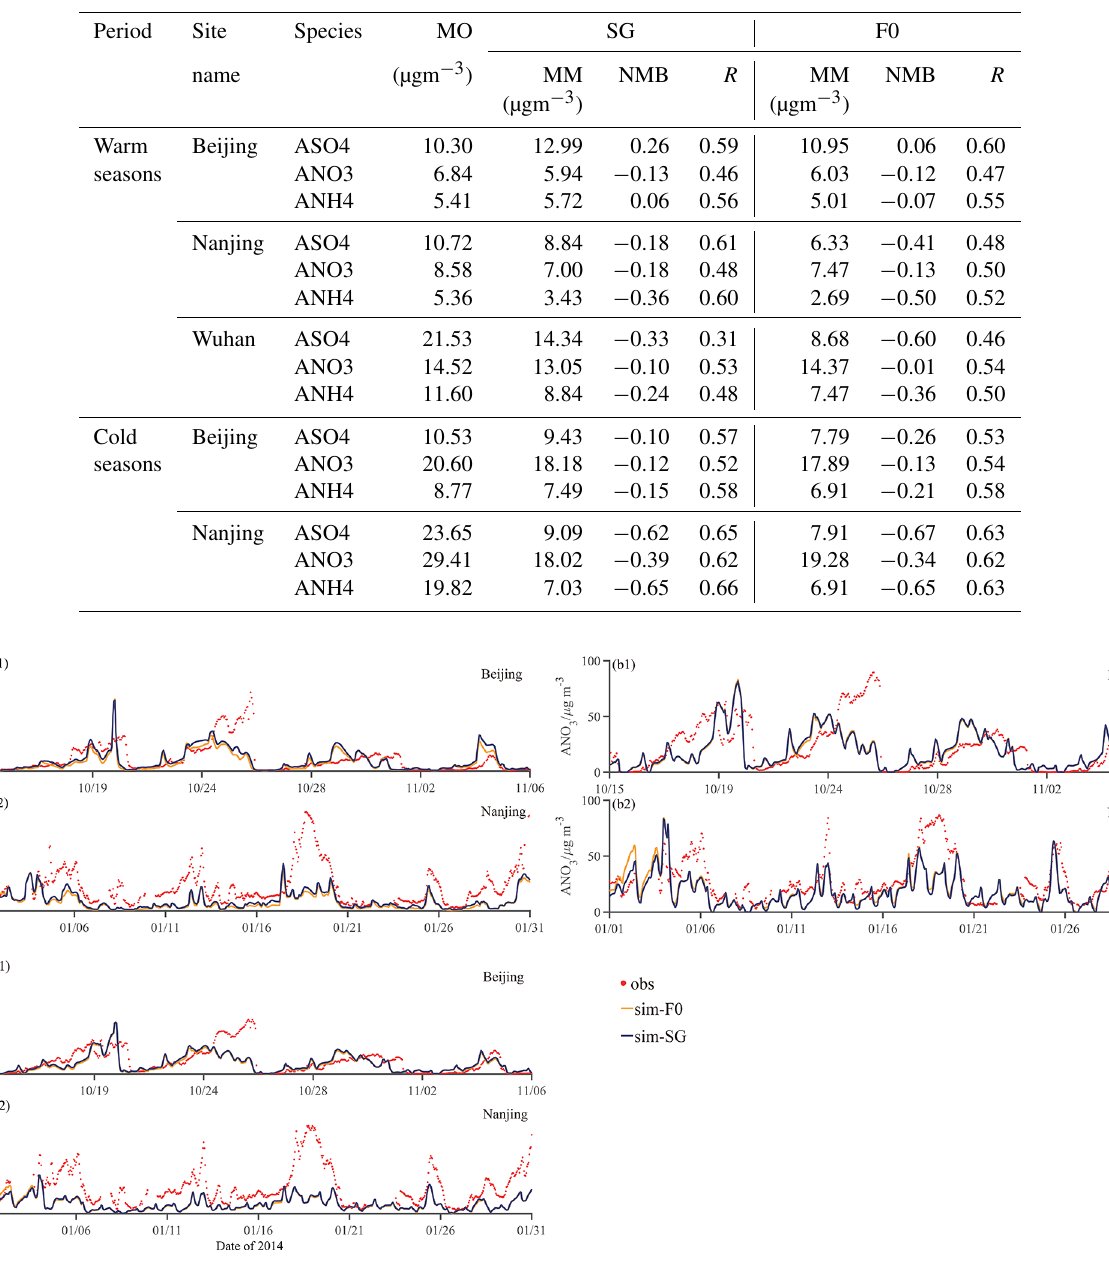
0.5 in Aitken mode (see in Table 5). This indicates that IAP- AACM coupled with the SGPF scheme reasonably captured the process of new particle formation in clean periods (e.g., 27–28 November, 5–6 December) and growth in haze peri- ods (e.g., 28–30 November). Here we also display the simu- lations of full spectrum of PNSD in F2.5 and SG in Fig.